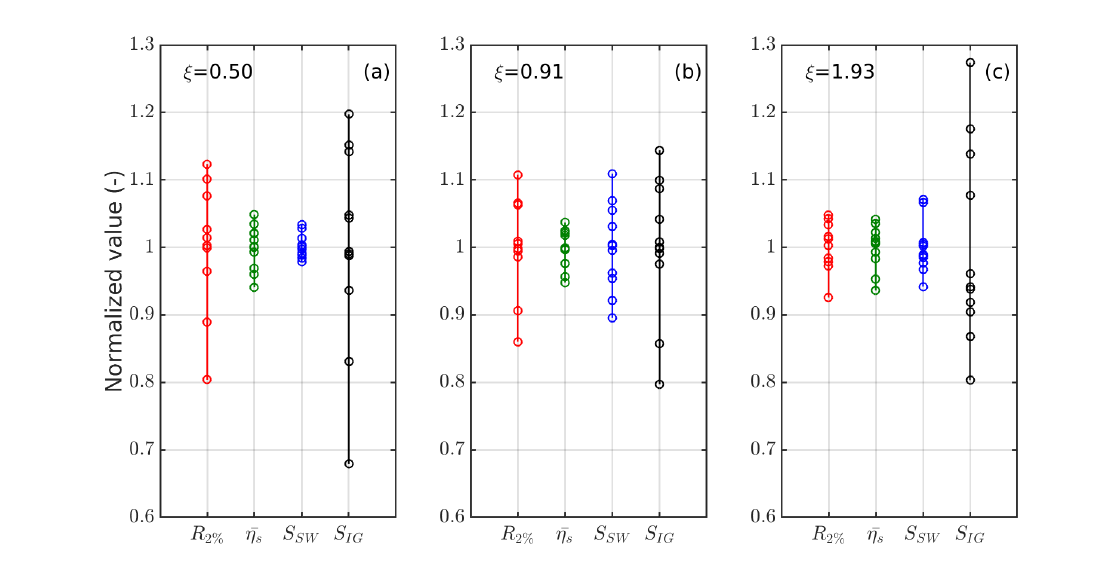
Figure 13. Runup components normalized by the mean value for the 10 random tests for case DR0 ( a ), case SBE2 ( b ), and case SBA1 ( c ). Red: R 2% , green: ¯ η s , blue: S SW , and black: S IG